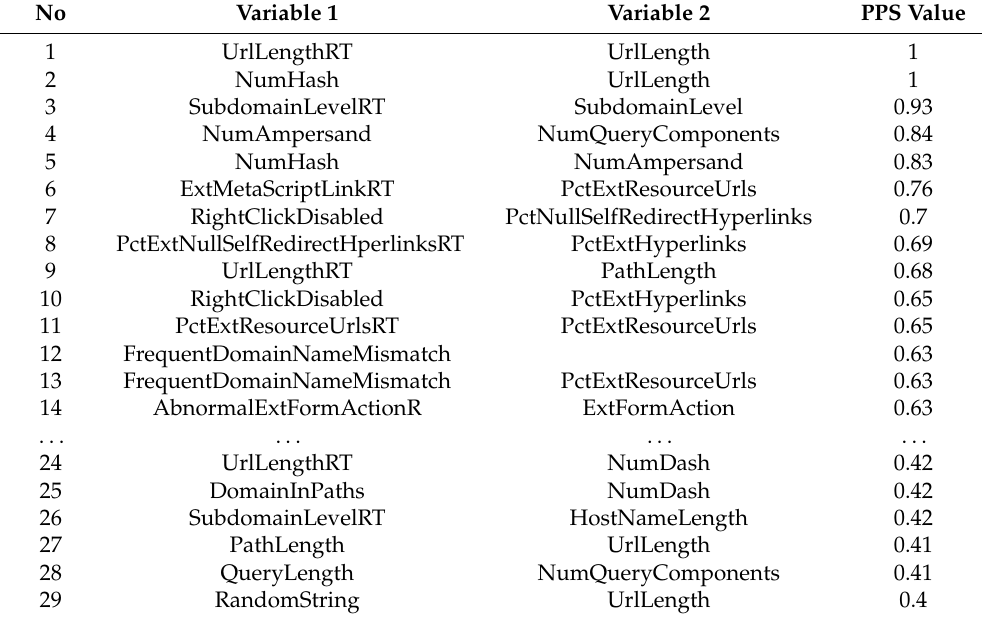
Table 3. PPS value between variables for dataset 1.